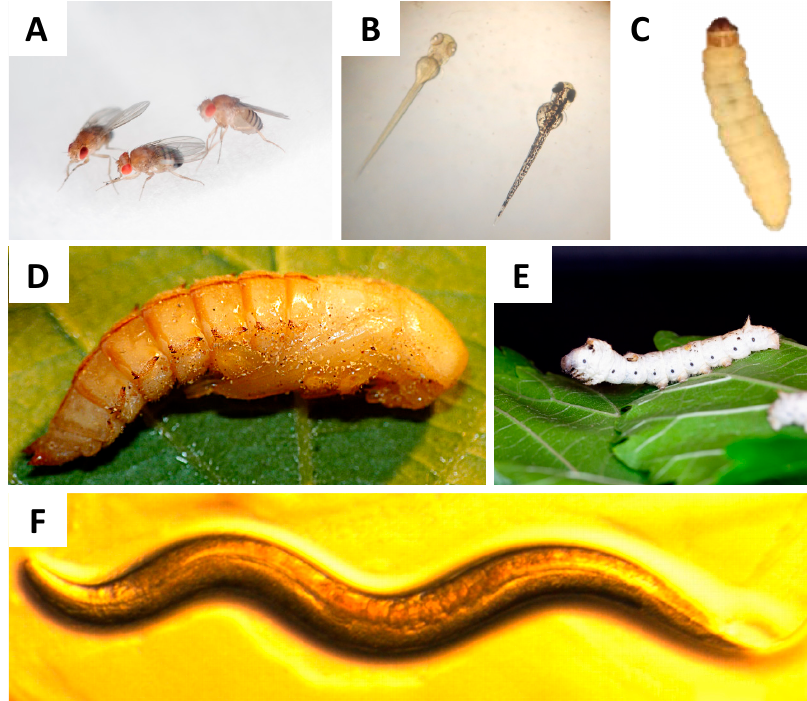
Figure 1. Alternative in vivo models for host–microbe interaction studies. ( A ) Adult D. melanogaster fly, whose size is approximately 3 mm. Original photograph by Flickr user NASA’s Marshall Space Flight Center, CC BY-SA 2.0 license. ( B ) Danio rerio larval size can range from 3.5 mm to 11 mm